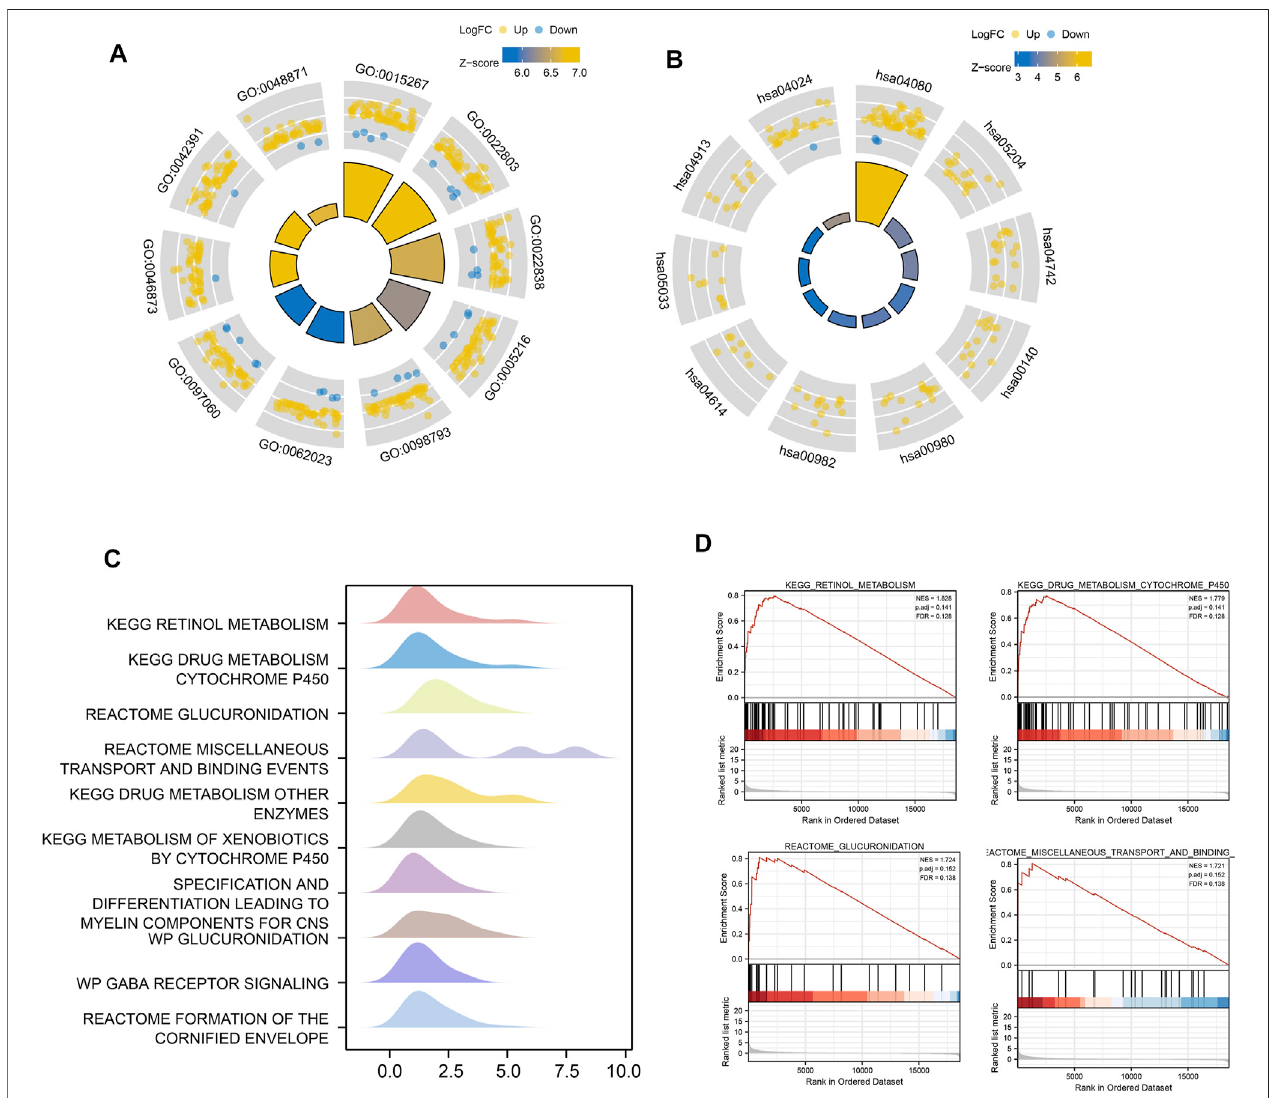
FIGURE 6 | Functional enrichment analysis of DEGs based on MDN1 gene mutation. (A) The circle diagram shows the GO term where DEGs are mainly enriched; (B) The circle diagram shows the KEGG pathway where DEGs are mainly enriched; (C) GSEA mountain range plot showing the top 10 GSEA enriched pathways accordingtoNES; (D) Topfour GSEA enriched pathways. NES valuerepresentsthenormalized enrichmentscore;thelargertheNES value,higher thenumberofgenes enriched in that pathway; p -value re fl ects the con fi dence of the enrichment results.